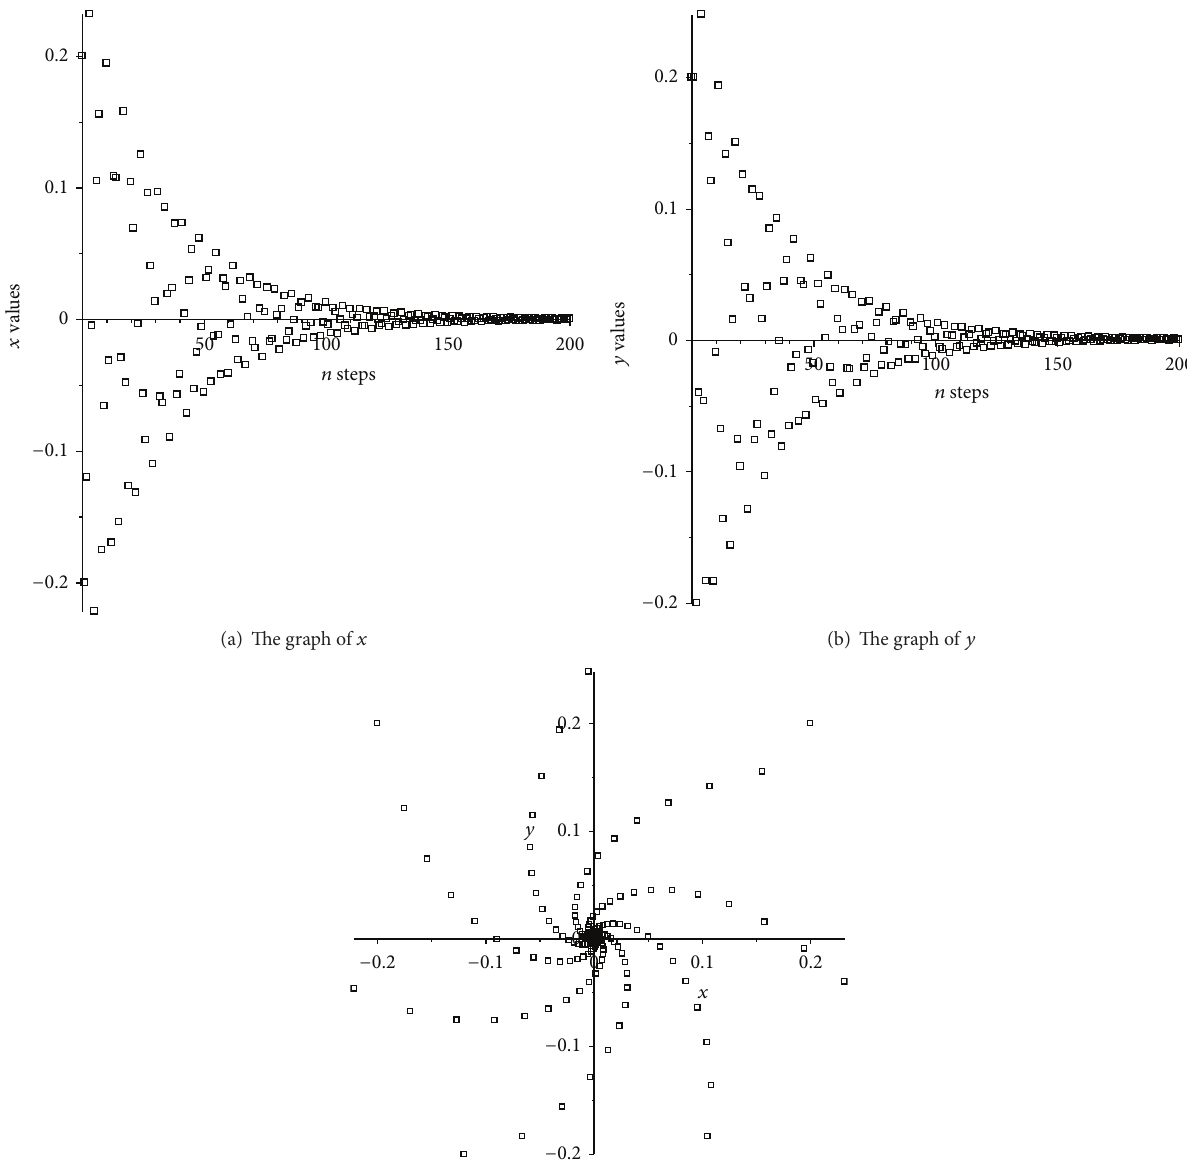
Figure 1: The solution of the Caputo-type fractional-order difference initial value problem for linear system (21) with the initial condition 𝑥(0) = 0.2 , 𝑦(0) = 0.2 , where the matrix 𝐴 is given in Example 40 and 𝛼 = 0.8 , ℎ = 0.5 . In this case the roots of (53) are strictly inside the unit